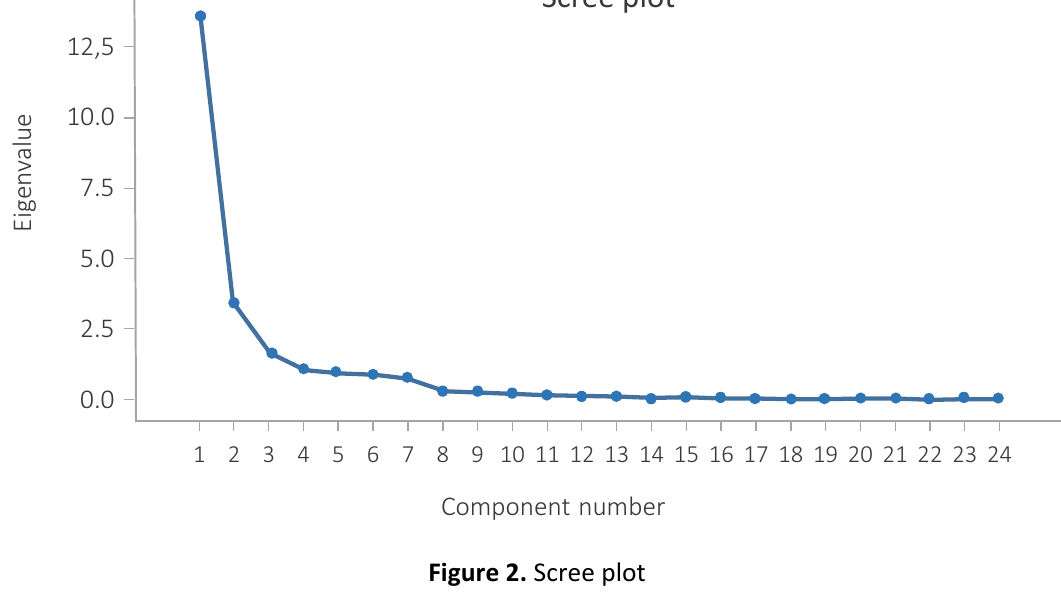
Figure 2. Scree plot